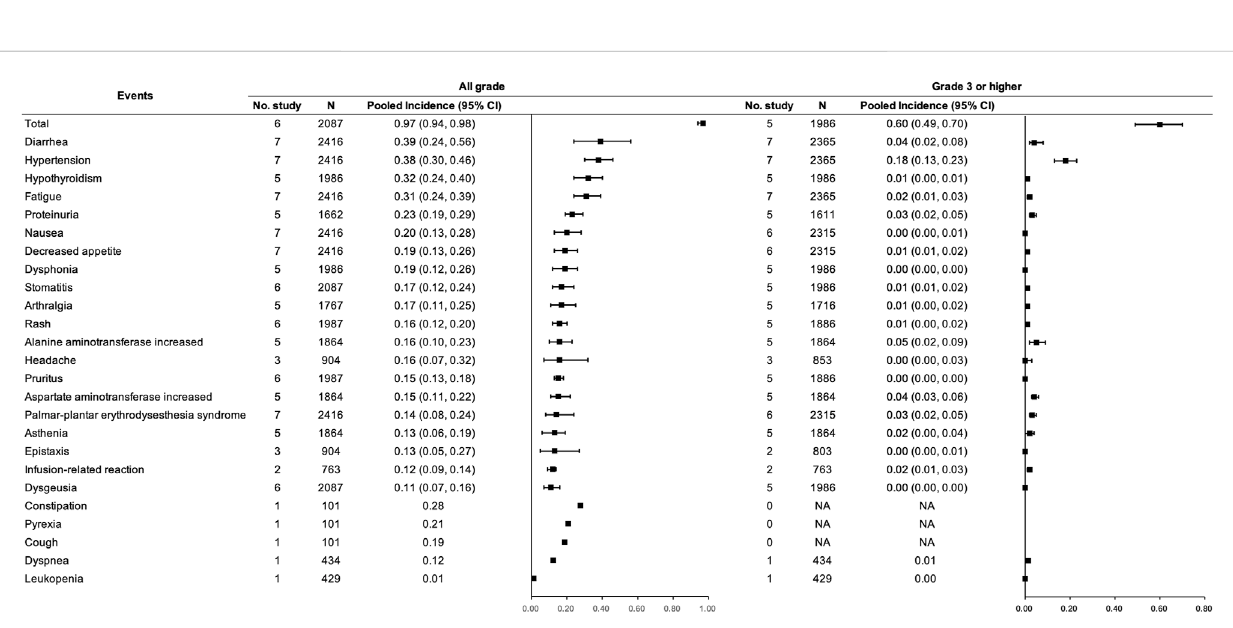
FIGURE 6 Incidence of trAEs for PD-(L)1 inhibitors combined with anti-VEGF(R) agents therapy. Note: An incidence of 0.00 indicates a rate < 0.005.